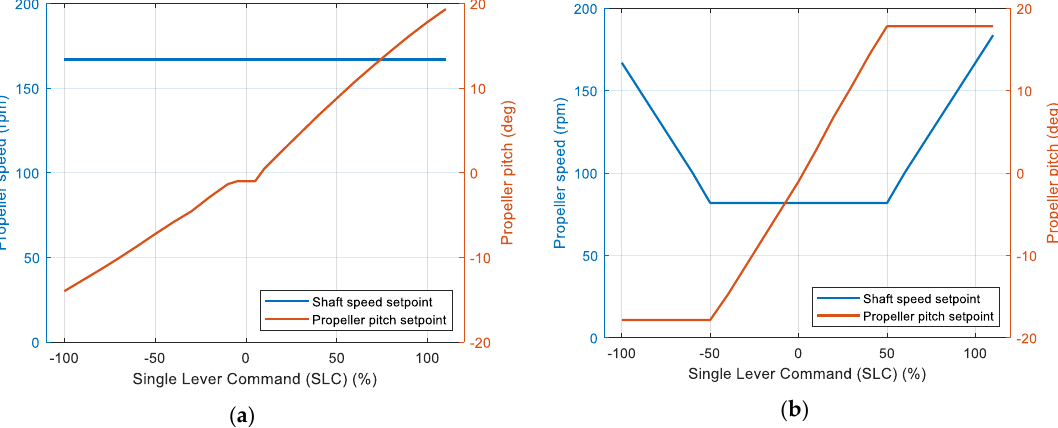
Figure A5. Combinator curve of different propulsion control modes. ( a ) Constant revolution mode, and ( b ) constant pitch mode.